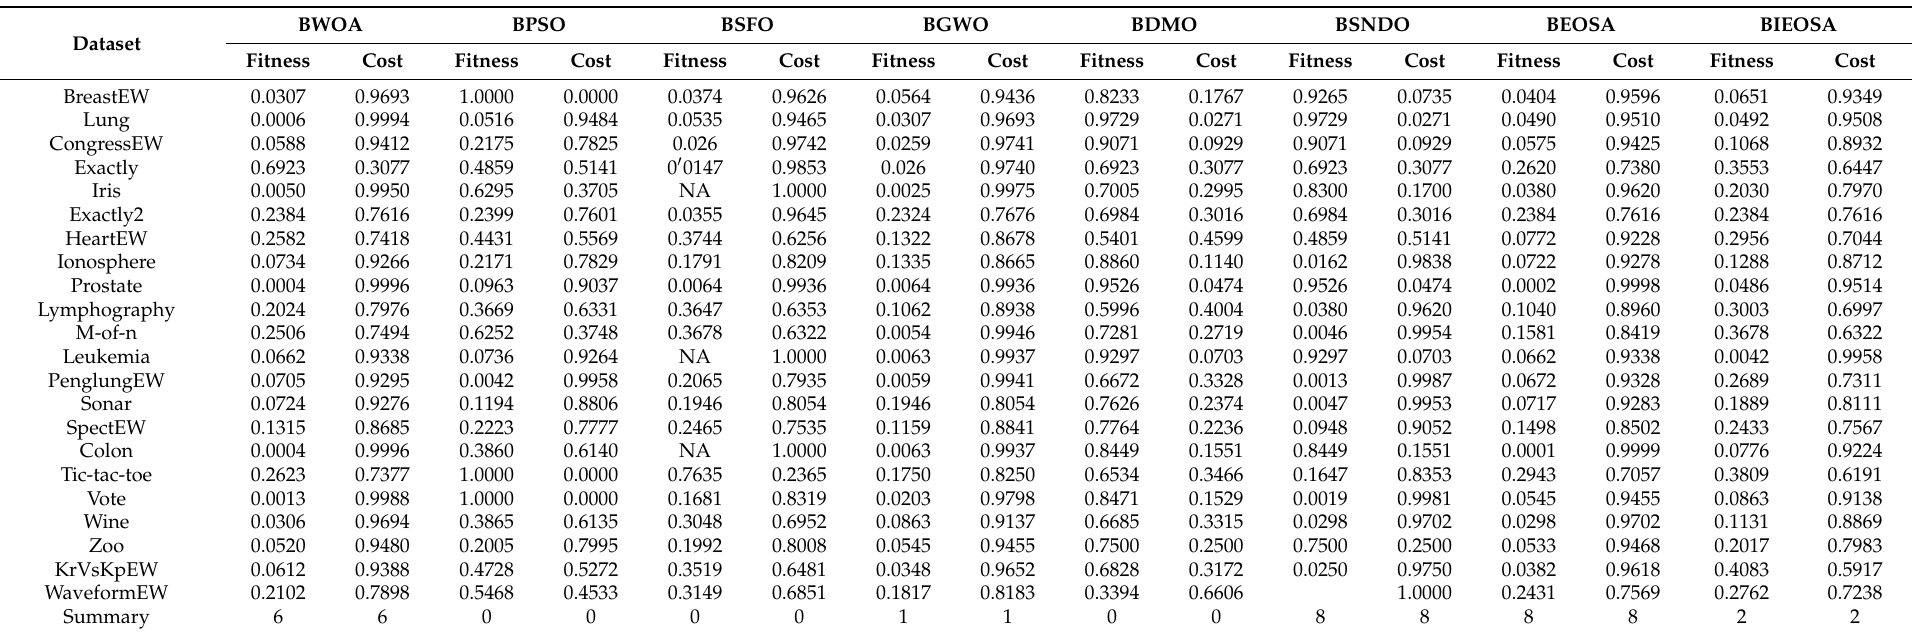
Table 3. Results of fitness and cost functions for BWOA, BPSO, BSFO, BGWO, BDMO, BSNDO, BEOSA and BIEOSA on all benchmark